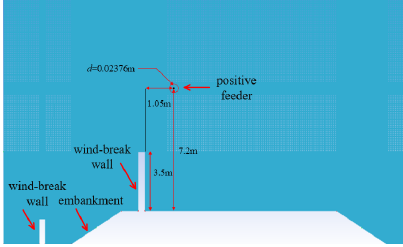
Fig. 2. Mesh of the entire fluid computational domain